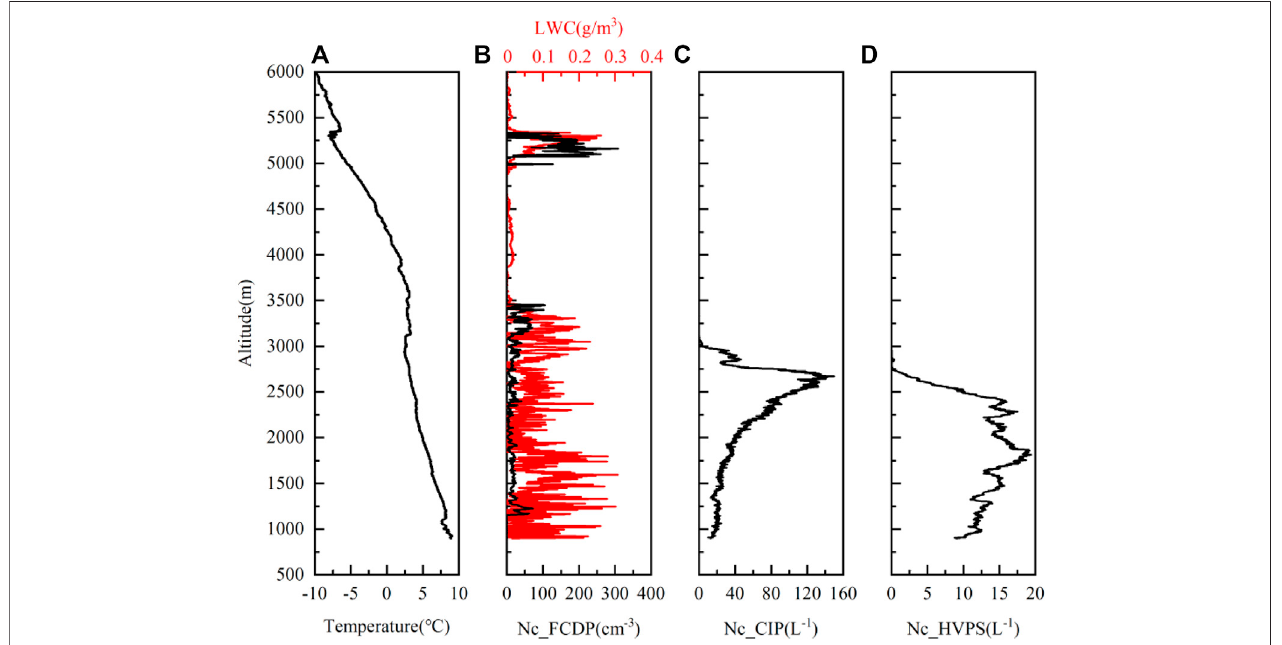
FIGURE5| Theverticaldistributionof (A) atmospheretemperature, (B) cloudparticlenumberconcentrationmeasuredbyfastclouddropletprobeandliquidwater content measured by Nevzorov, (C) cloud particles larger than 100 µm number concentration measured by cloud imager probe, and (D) cloud particle number concentration measured by a high-volume precipitation